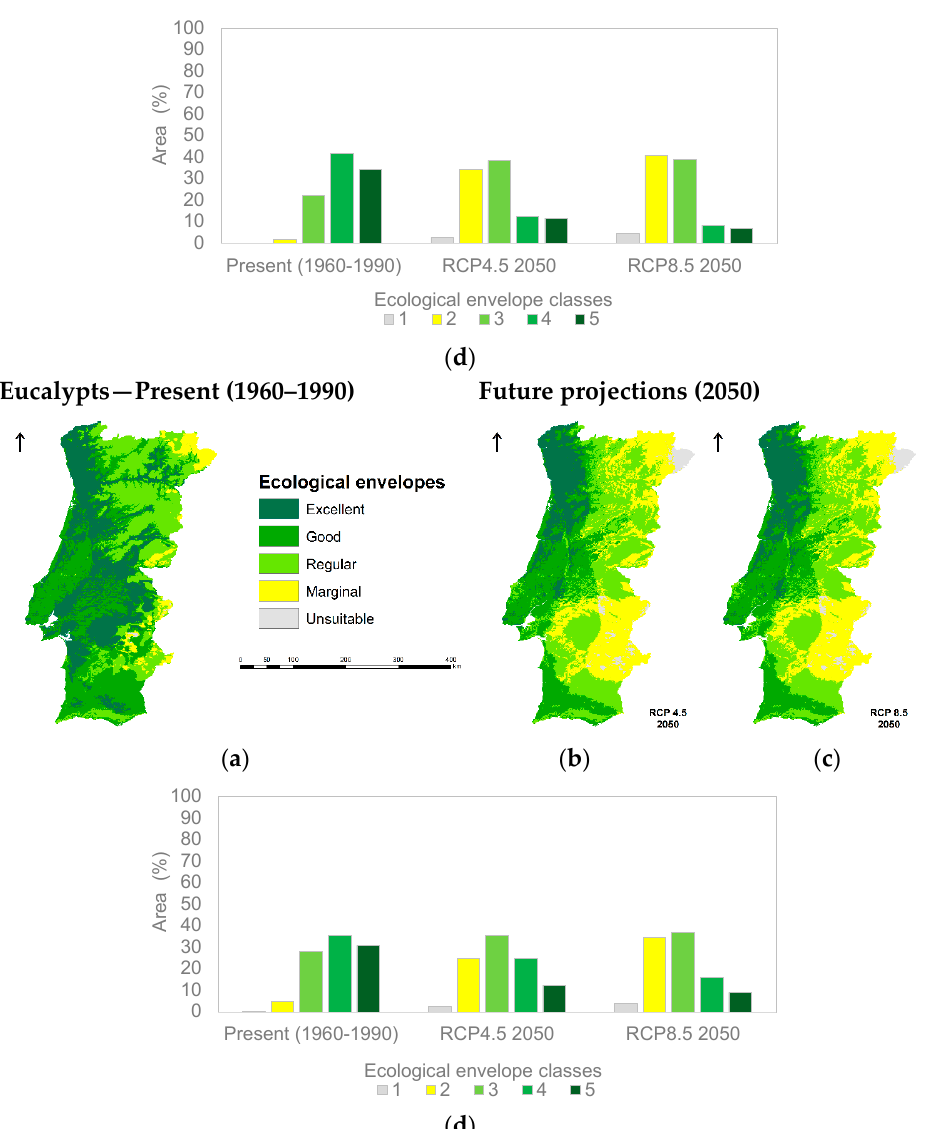
Figure 5. Species ecological envelopes: ( a ) Present (1960–1990); ( b ) Future RCP4.5 scenarios for 2050; ( c ) Future RCP8.5 scenarios for 2050; ( d ) Ecological envelopes classes percentage areas distribution.